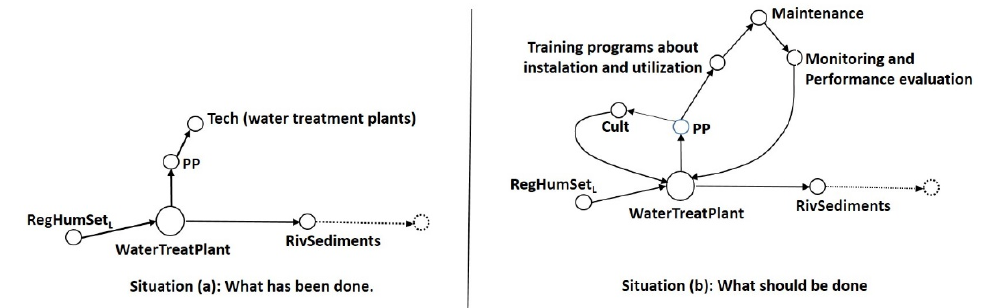
Figure 7. Situation ( a ) shows that the implementation of a water treatment plant took place without considering a previous training technical program related to the water treatment plant to be in- stalled. Situation ( b ) shows the main actions to be implemented before and after the installation of a water treatment